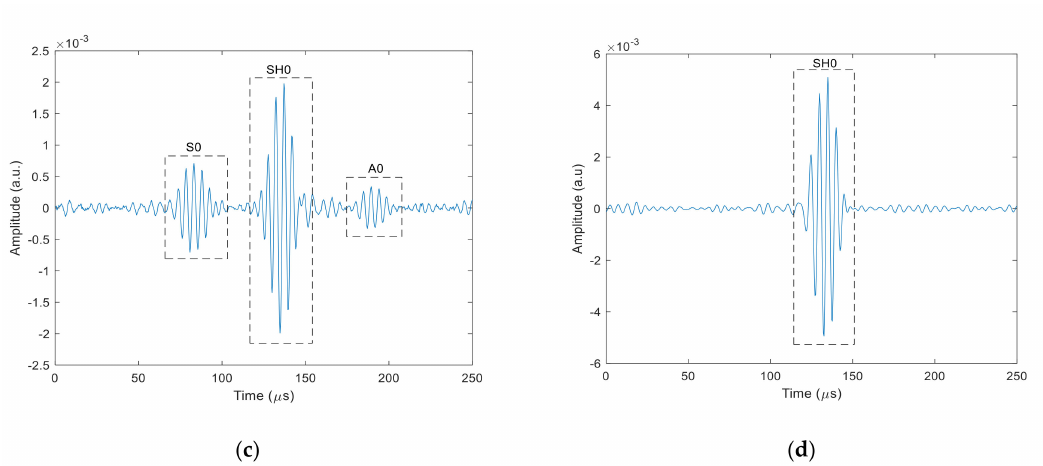
Figure 16. ( a – d ): Examples of waveforms detected by the laser vibrometer at a distance of 0.35 m in the stainless steel plate for Configurations 1–4, respectively, at 1 160 ◦ , 2 at 90 ◦ , 3 at 90 ◦ and 4 at 0 ◦